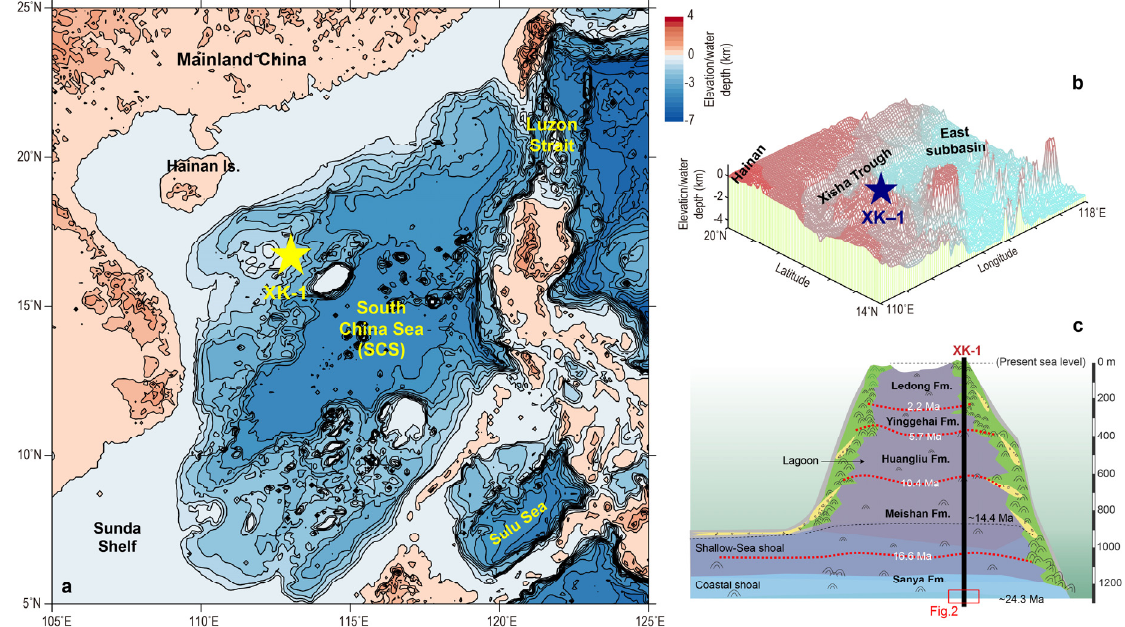
Figure 1. Study area and the location of core XK-1. ( a ) The South China Sea (SCS). ( b ) Topography of Xisha (Paracel) Islands. ( c ) The skeleton of the Shidao Island with the five formations identified in regional studies. The age boundary of each formation was from [18], and the skeleton ( c ) was modified from previous reports [26,34,35]. The base map data were generated using the open and free software DIVA–GIS 7.5 (http://www.diva-gis.org/, accessed on 10 September 2021).